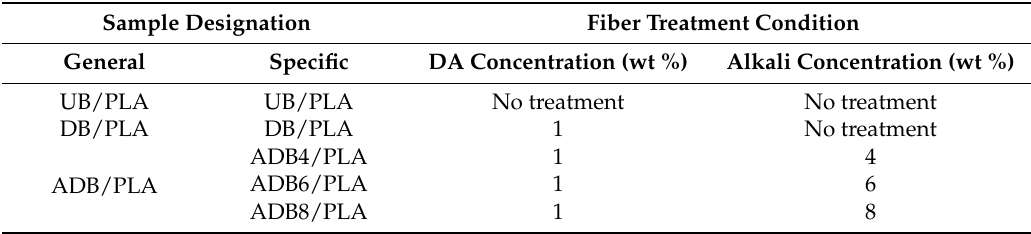
Table 1. The designations of the control and the experimental group in this study. BF: bamboo fiber;